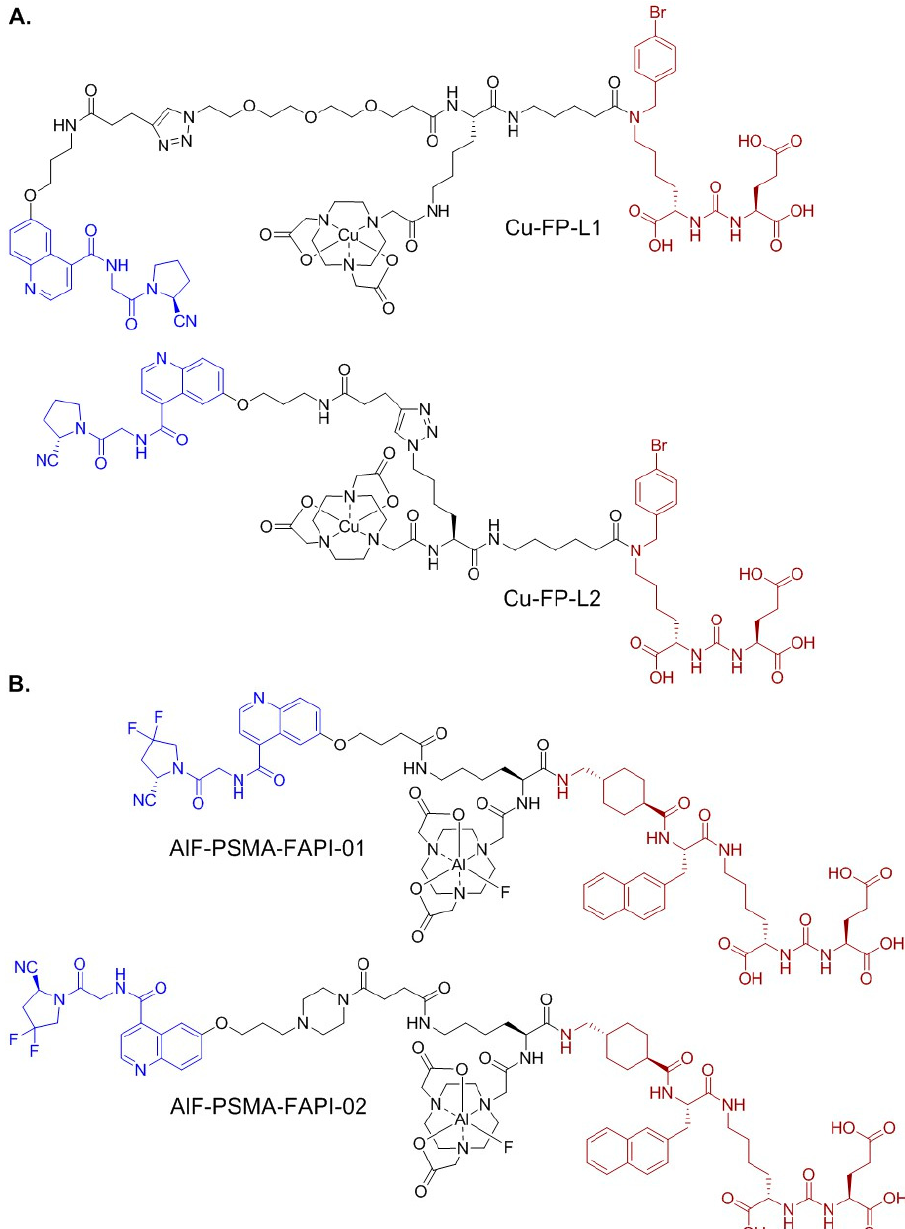
Figure 1. Chemical structures of ( A ) Cu-FP-L1 and Cu-FP-L2; and ( B ) AlF-PSMA-FAPI-01 and AlF-PSMA-FAPI-02. The PSMA- and FAP-targeting pharmacophores are shown in brown and blue, re- spectively.